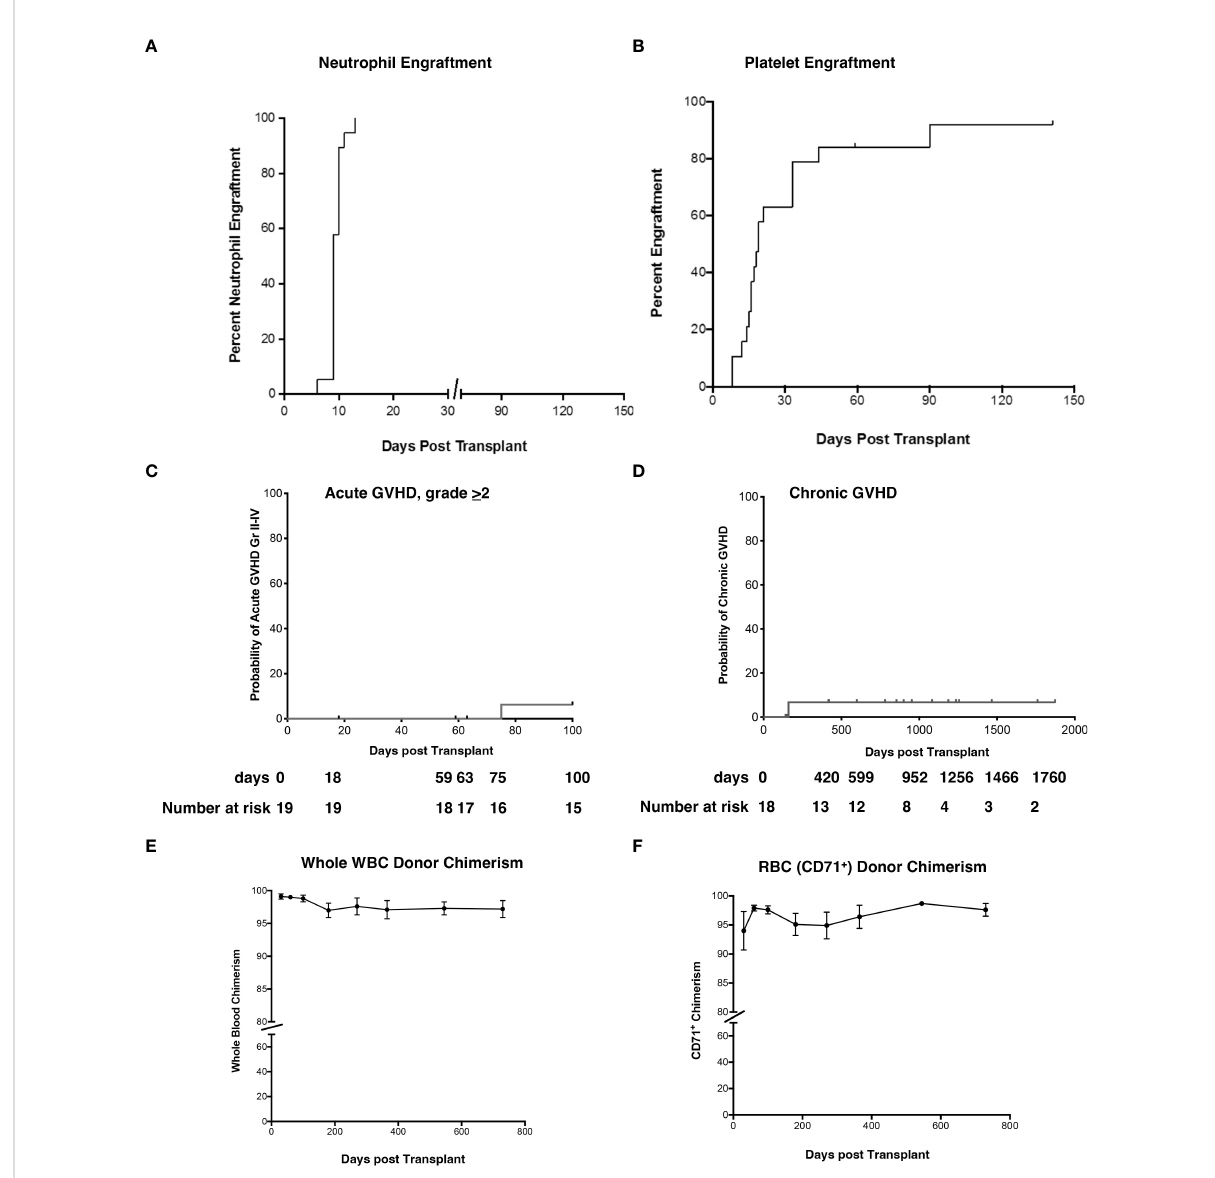
FIGURE 2 Neutrophil and platelet engraftment, cumulative incidence of Grade II-IV aGVHD and cGVHD, and whole blood and RBC donor chimerism. (A, B) The probability of neutrophil and platelet engraftment, (C) cumulative incidence of aGVHD, (D) cGVHD, (E) donor chimerism in whole blood, and (F) RBC (erythrocyte enriched fraction) were determined using the product limit method of Kaplan and Meier. Donor chimerism (% donor) was determined at 30d, 60d, 3-month, 6-month, 1 yr, and 2 yr post-HSCT. Panel E is peripheral blood and panel F represents RBC. Results are shown as the mean ± SEM. aGVHD, acute graft versus host disease; RBC, red blood cells; cGVHD, chronic graft versus host disease; HSCT, hematopoietic stem cell transplantation; SEM, standard error of the